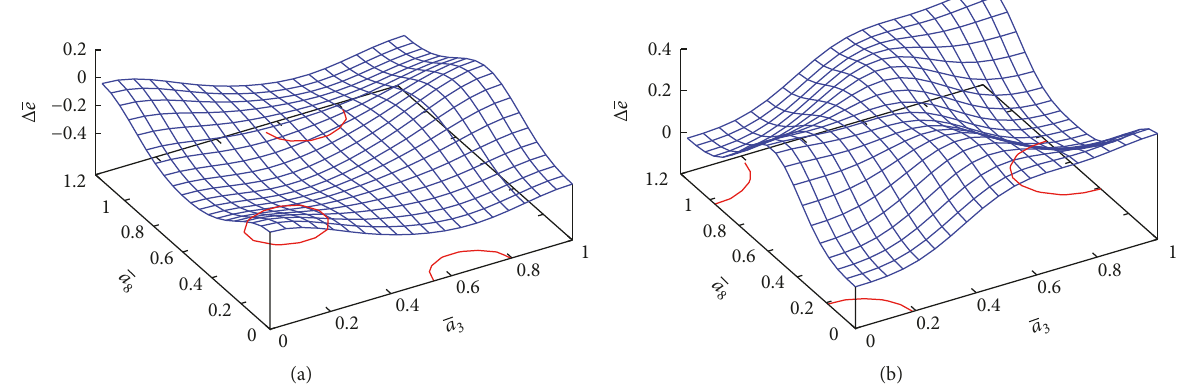
Figure 18: The effective potential of the Polyakov loop for the gauge group SU (3) as function of the two Cartan components of the background field 𝑥 = 𝑎 3 𝐿/2𝜋 and 𝑦 = 𝑎 8 𝐿/2𝜋 for (a) 𝑇 < 𝑇 푐 and (b) 𝑇 > 𝑇 푐 .